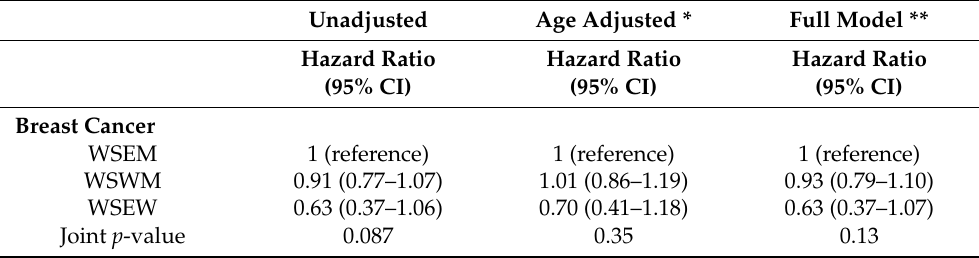
Table 4. Models of breast, lung, and colorectal cancer in